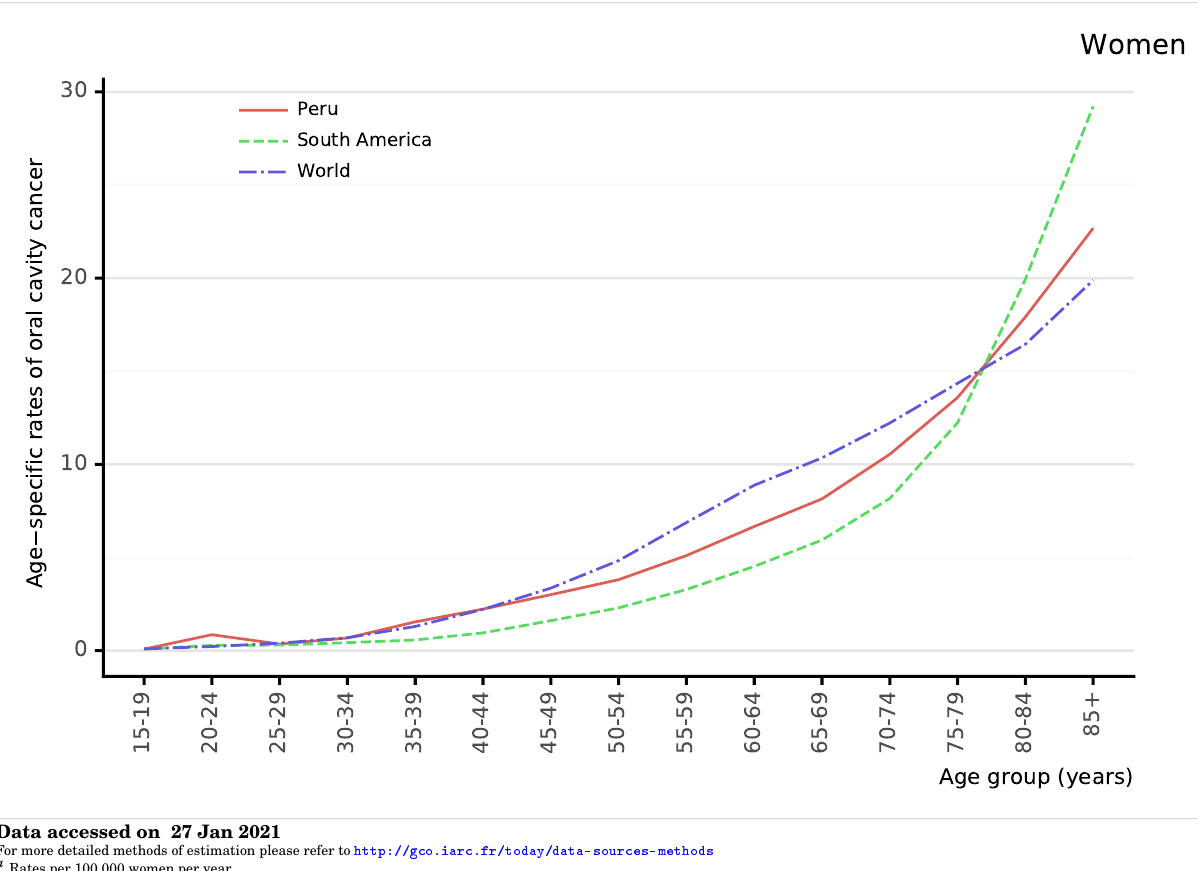
Figure 99: Comparison of age-specific oral cavity cancer incidence rates among women by age in Peru, within the region, and the rest of